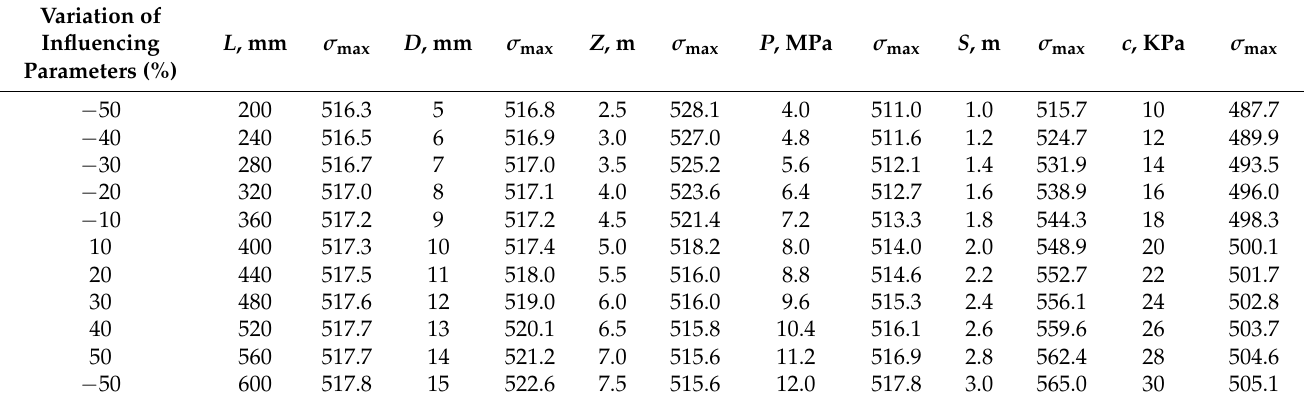
Table 4. Summary of maximum von Mises stress of pipeline (MPa).